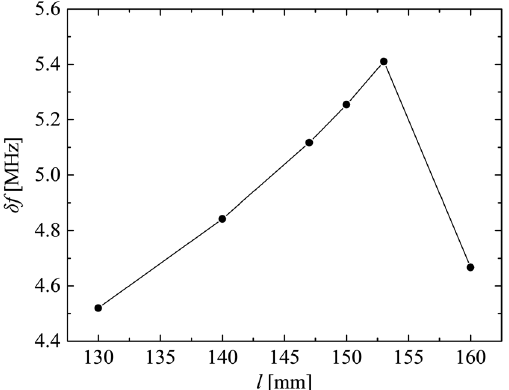
FIG. 18. Measured frequency interval between the operating mode and nearest dipole modes with the rod